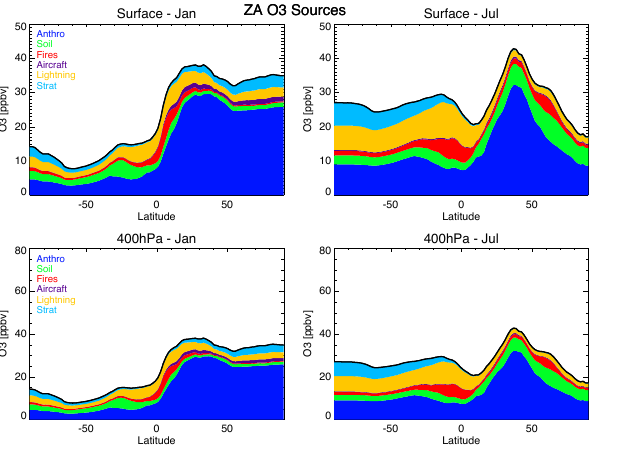
Fig. 6. Zonal average of tagged ozone source contributions at the surface and at 400hPa, for January and July of 2008. Stratospheric contribution is determined as the difference between total ozone and tagged ozone from all tropospheric sources combined.